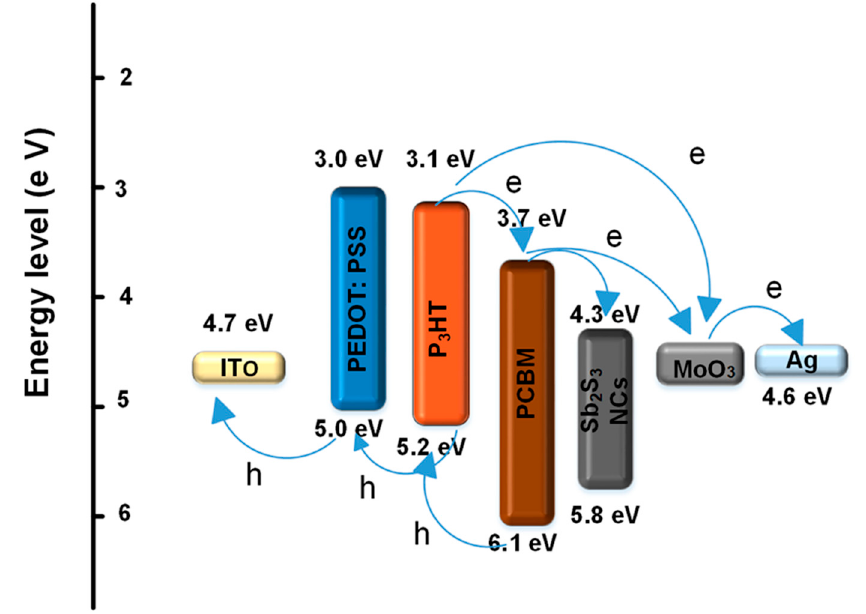
Figure 6. Energy band diagram and charge transfer effects of the P 3 HT, PCBM, and Sb 2 S 3 NCs.